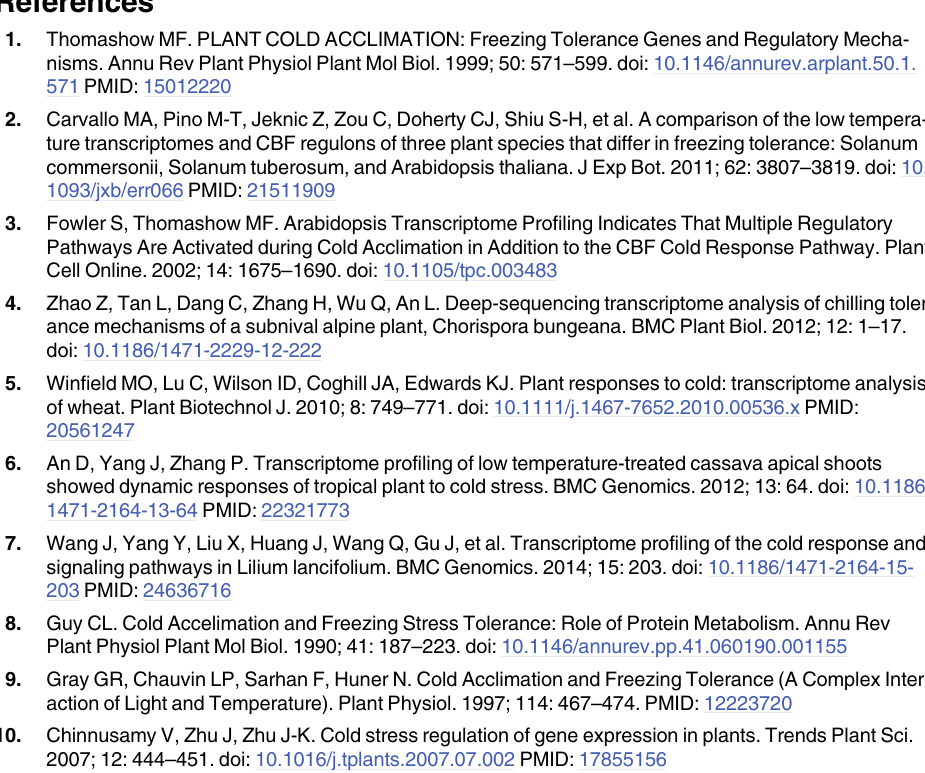
S2 Fig. HbCBF1 overexpression decreased the plant height in Arabidopsis . Arabidopsis seed- lings of col-0 and HbCBF1 overexpression lines OE3, OE6 and OE13 were cultured as described in Material and methods . The seedling height was measured at 30 days old. The data were pre- sented as mean ± standard error of mean of 15 to 20 plants. Star symbol ( (cid:1) ) shows the signifi- cance when compared with col-0 plants. The statistical significance analysis was performed by using the Student ’ s t -test, and p < 0.05 was recognized as significant. (PDF) S3 Fig. HbCBF1 overexpression activated the expression of COR6 . 6 , COR47 and RCI2A genes in Arabidopsis . AtCOR47 (A) , AtCOR6 . 6 (B) and AtRCI2a (C) expression in col-0 , OE- 3, OE-6 and OE-13 plants under nonacclimated (control), 5-day cold-acclimated (cold) or 10-days drought stress (drought). Data were presented as mean ± standard error of mean of three biological replicates. Significance was determined by Student ’ s t test at the probability lev- els of P < 0.05. S1 Table. List of oligonucleotide sequences used in this